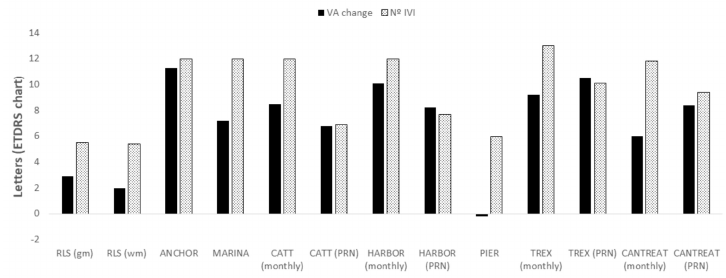
Figure 5. Mean change from baseline in visual acuity (VA) and number of intravitreal injections (IVI) in real-world studies and randomized controlled trials after 12 months of ranibizumab treatment in patients with neovascular age related macular degeneration. Real world studies results have been adapted from Chong [27] and Kim et al. [153]. RLS: Real-life studies; gm: grand means (mean of the means of the several studies); wm: weighted means (mean weighted against number of eyes per